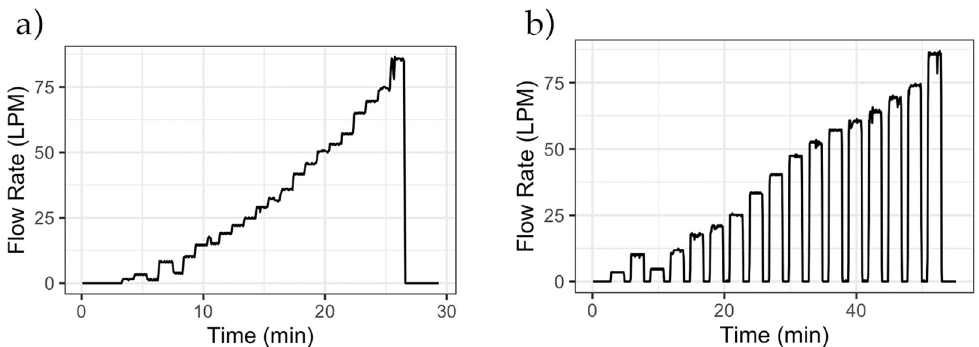
Figure 7. Flow signatures of the experiments used to verify the functioning of the CIWS datalogger: ( a ) increasing the flow rate gradually and ( b ) increasing the flow rate with intervals of no flow. Data shown are for a 5/8 in Neptune T ‐ 10 meter.